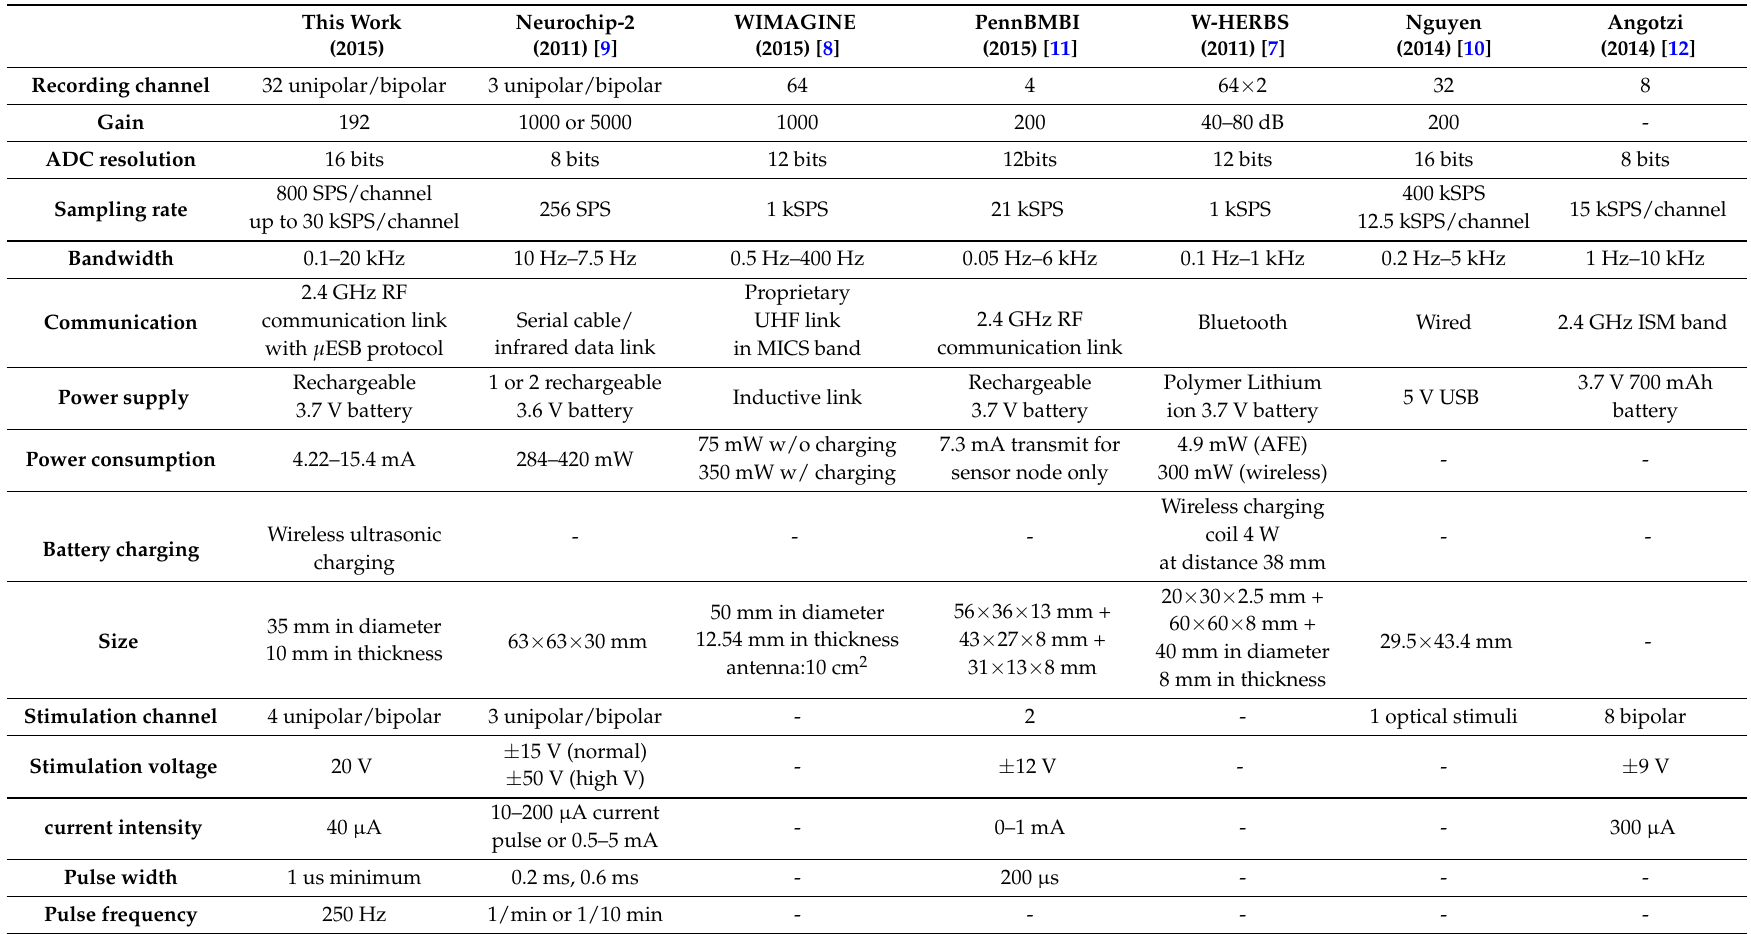
Table 3. Comparison of state of the art works. SPS, samples per second; ESB, Enhanced